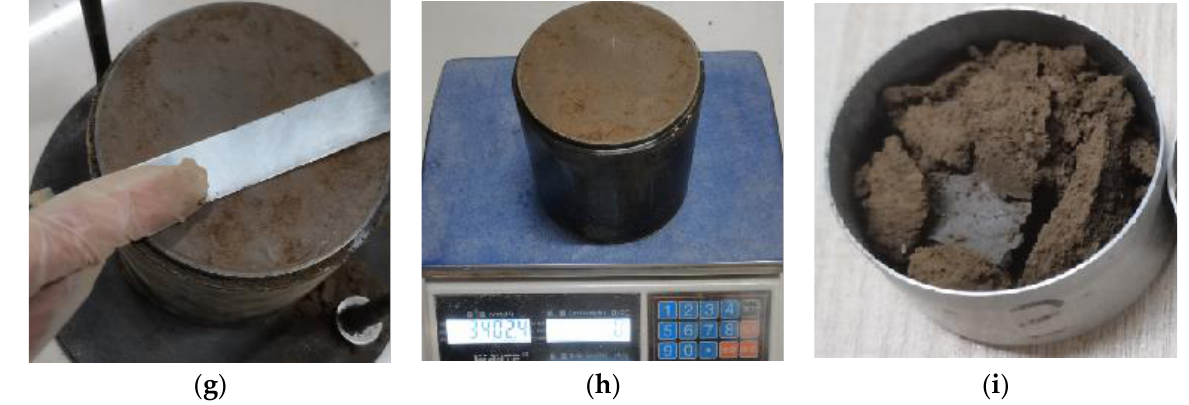
Figure 4. Compaction test of ( a ) soil sample preparation, ( b ) net weight weighing of compaction cylinder, ( c ) placing plastic film on the spacer, ( d ) assembly of instrument, ( e ) compaction, ( f ) layered shaving, ( g ) topsoil sample troweling, ( h ) weighing, ( i ) water content measuring.